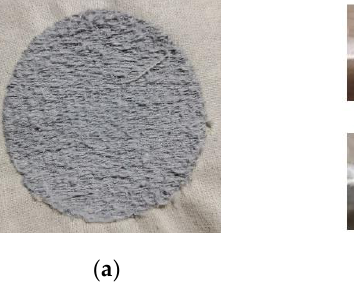
Figure 7. State of stainless steel embroidery fabric electrode face after pilling ( a ). The pilling height of the embroidery fabric electrode was observed from different directions ( b ). In the process of making an embroidery fabric electrode, the surface of the embroidery fabric electrode is divided into transverse and longitudinal directions because of the directivity of the embroidery needle. The yarn contact mode is different in different directions and the resistance distribution is also different ( c ).